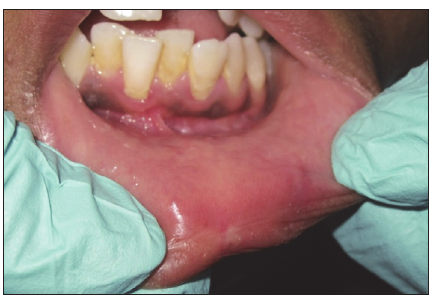
Figure 11: Photograph showing postoperative view: Day